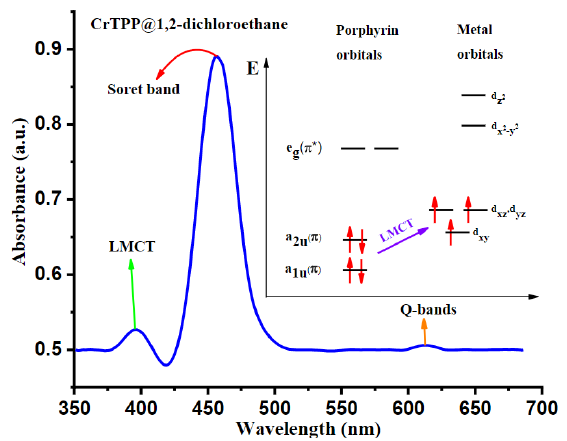
Figure 2. UV–Vis spectrum of the LMCT electronic transition mechanism. Koushik et al., J. Photochem. Photobiol. Chem., 2022, 427: 113811 [7], with permission of Elsevier.